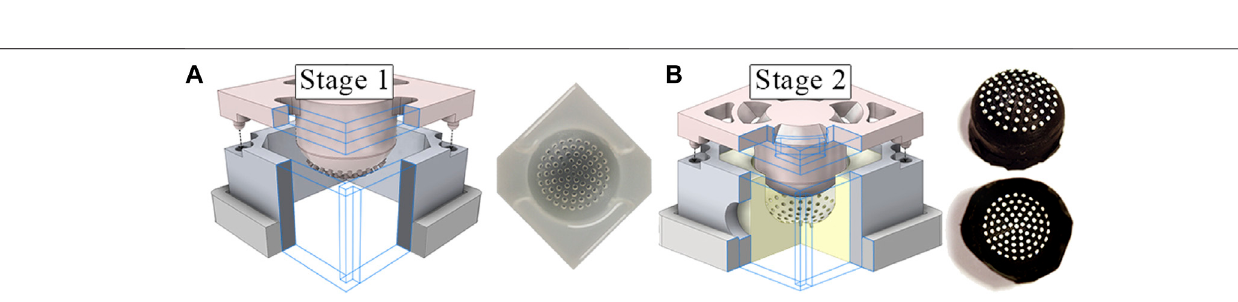
FIGURE 2 | High level system diagram for an optical based tactile sensor incorporating pneumatic actuation.